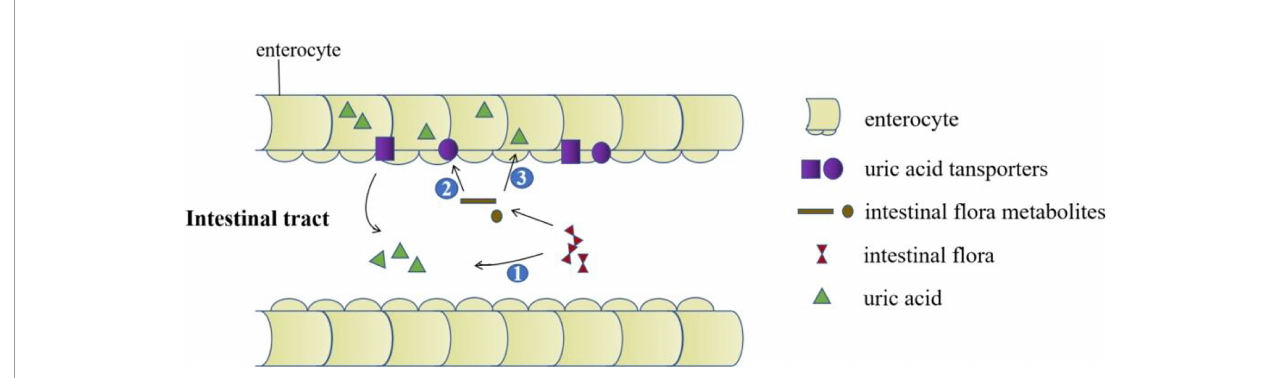
FIGURE 3 | The role of the intestinal tract in uric acid excretion. The intestinal fl ora decomposes the uric acid directly. Intestinal fl ora metabolites upregulate the expression of uric acid transporters. Metabolites produced by intestinal fl ora promote the excretion of uric acid by providing energy for intestinal epithelial